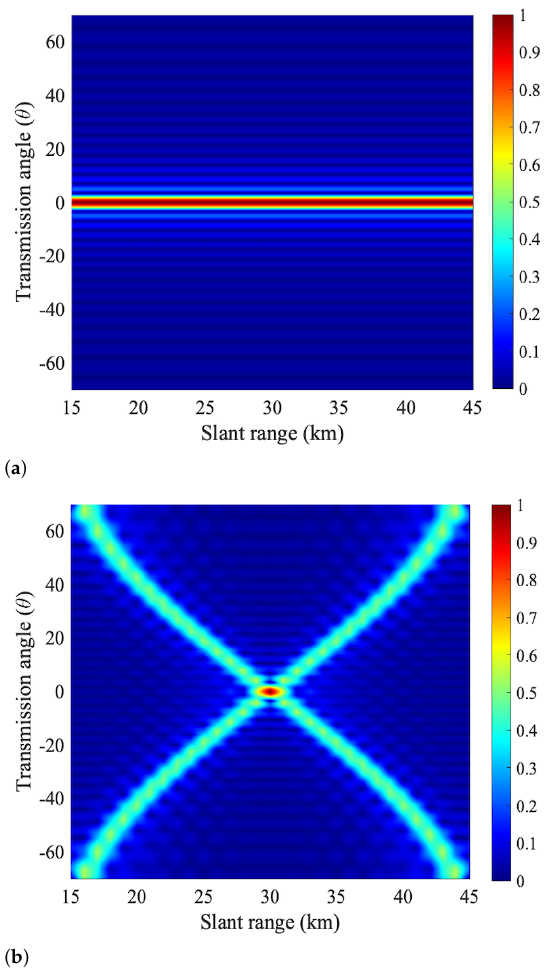
Figure 1. Beampattern synthesis results. ( a ) Phased array, ( b )